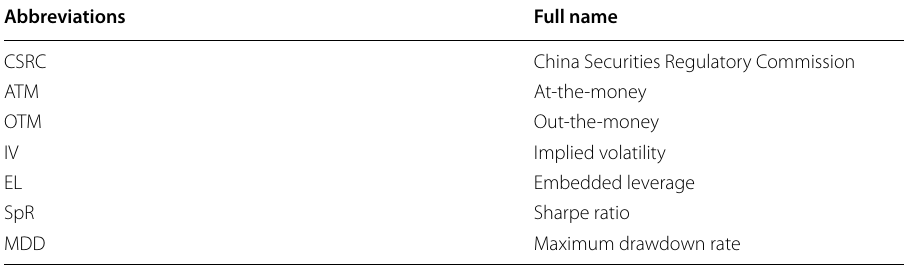
Table 11 Abbreviation